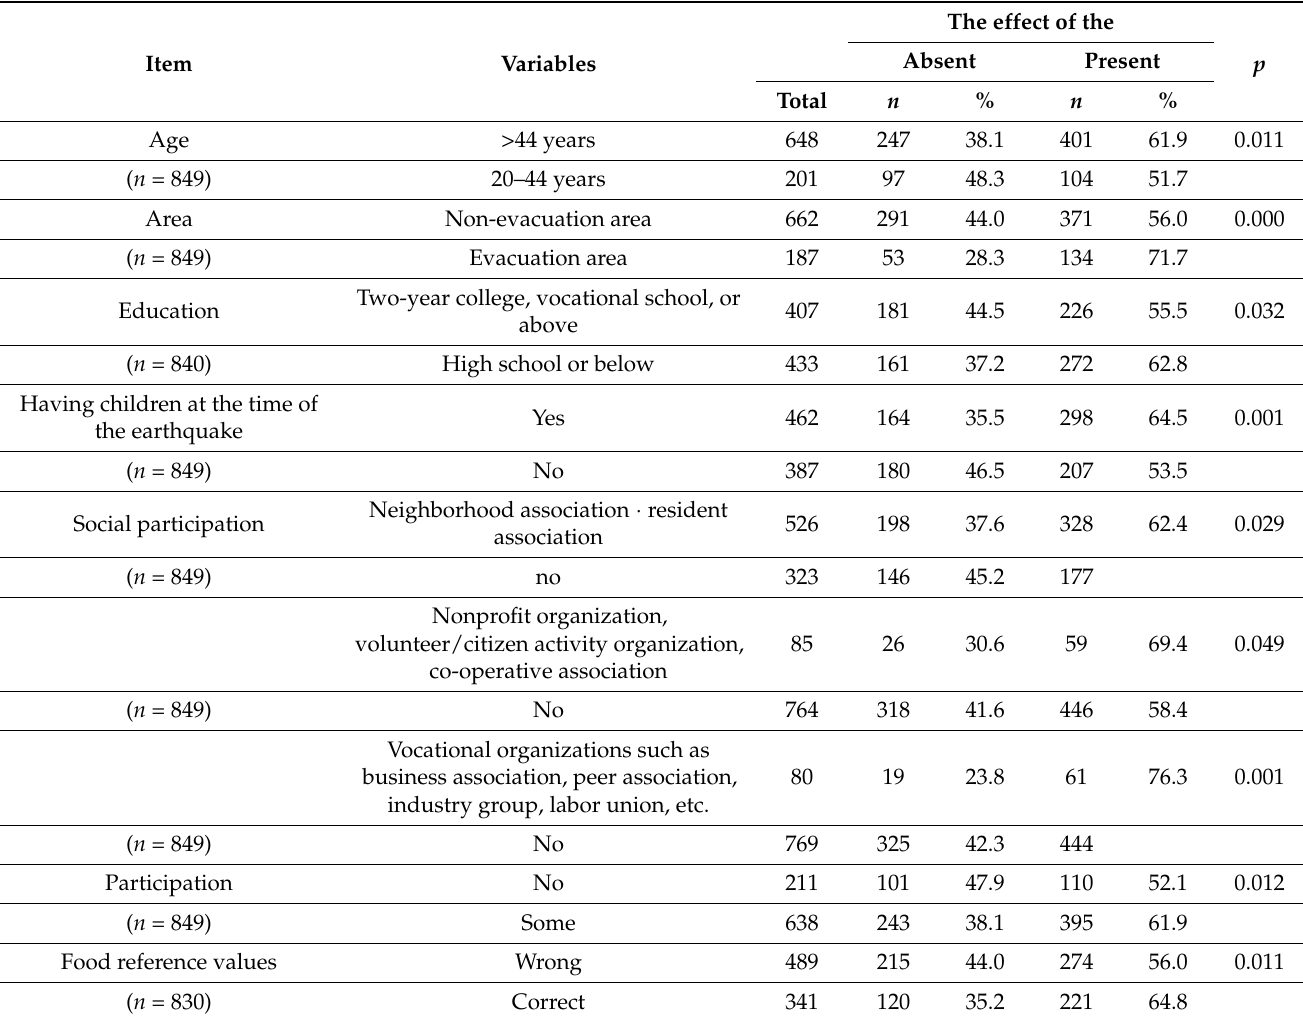
Table 5. Results of the univariate analysis for other items with the effect of perceived DCBHR as the response